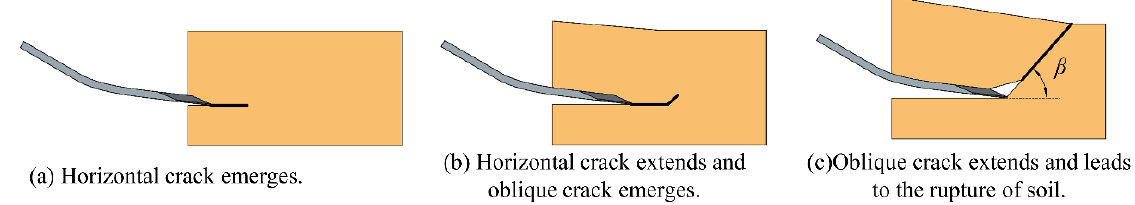
Figure 13. Soil failure of run No. 12. Displacement contour plot (left) and equivalent plastic strain contour plot (right).